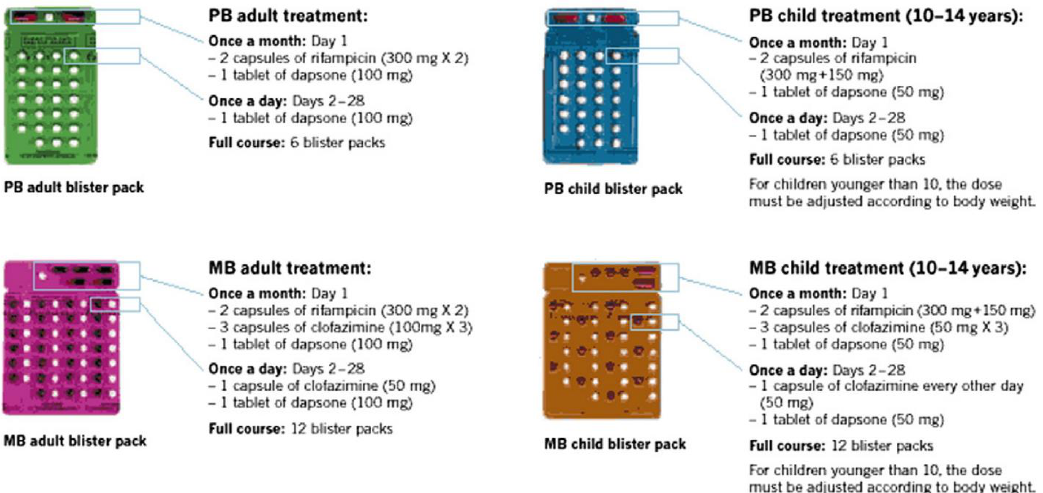
Figure 3. Examples of one month-pack blister freely distributed by WHO for adult and child leprosy treatment. Reproduced with permission from [32], Elsevier, 2015.